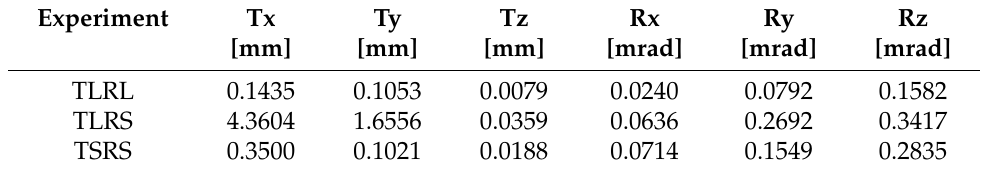
Table 2. RFB repeatability. Mean of the RMSE of the differences between the 4 repetitions per experiment.